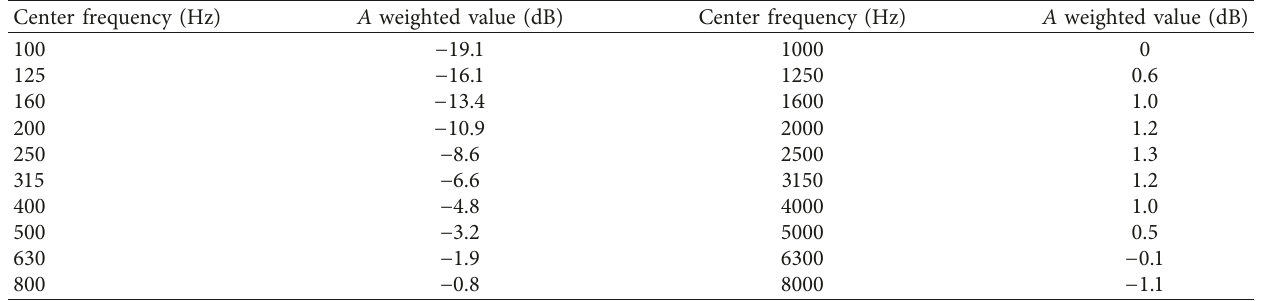
Figure 17: Spectrum of measured vibration signal and independent pure combustion noise. (a) 1500rpm and no-load condition and (b) 800rpm and no-load condition. Table 2: Frequency characteristic parameter of A weighted network.